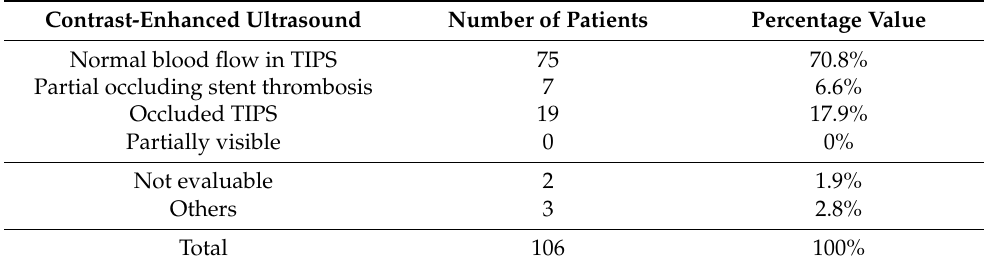
Figure 6. Same patient as in Figure 3. Contrast-enhanced ultrasound shows partial flow signal within the transjugular intrahepatic portosystemic shunt with marginal hypoechoic areas within the stent indicating thrombotic depositions. Table 2. Description of the patient cohort with regard to the results of contrast-enhanced